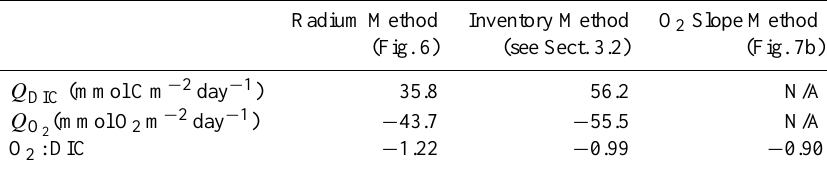
Table 2. Comparison of calculated DIC fluxes out of sediments (i.e. positive fluxes), O 2 fluxes into sediments (i.e. negative values), and resulting O 2 :DIC flux ratios.